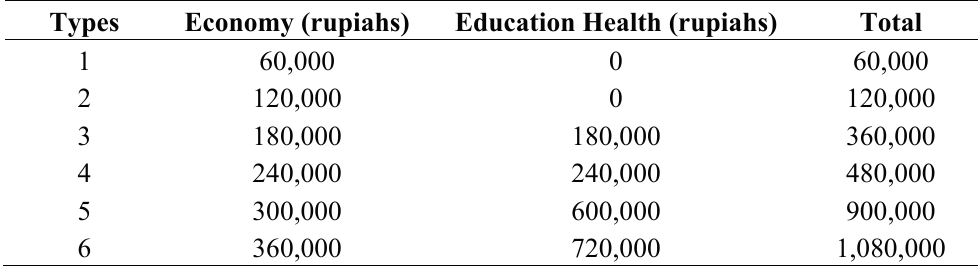
Table 5. Total amount of money participants can get annually. Source: LATIN (2011)